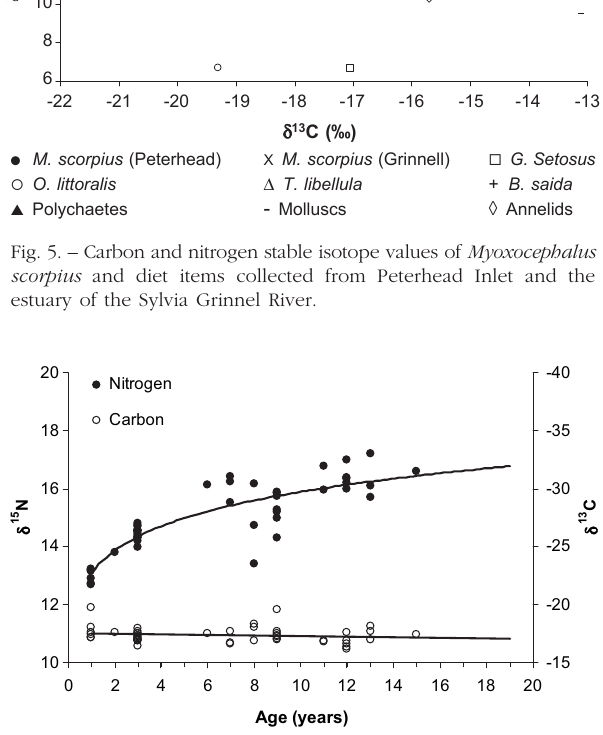
Fig. 6. - δ 15 N and δ 13 C stable isotopes plotted against age of shor- thorn sculpin from Peterhead Inlet and the Sylvia Grinnell River estuary,